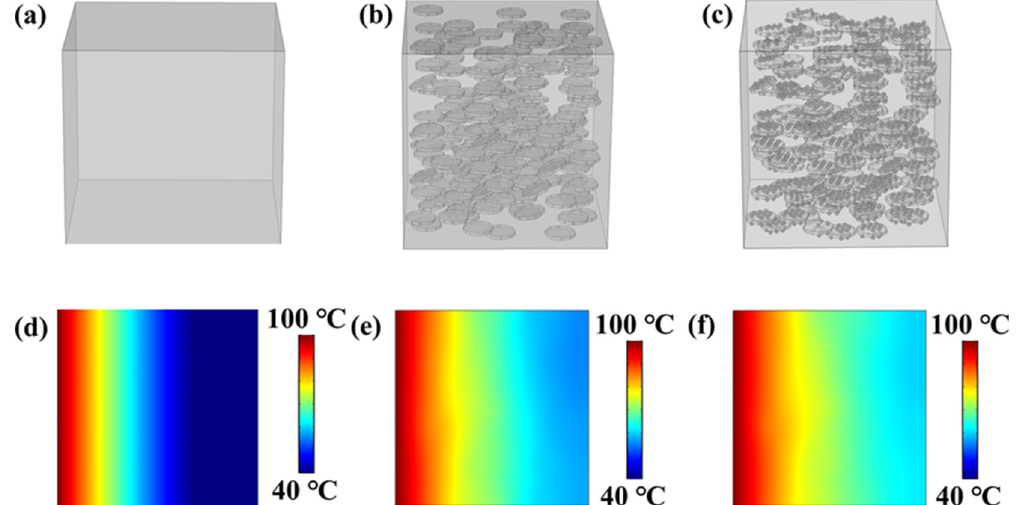
Figure 8. Finite element simulation of the variation of heat transfer of ( a , d ) the pure ANF, ( b , e ) ANF/BNNS, and ( c , f ) ANF/BNNS@Ag nanocomposites.